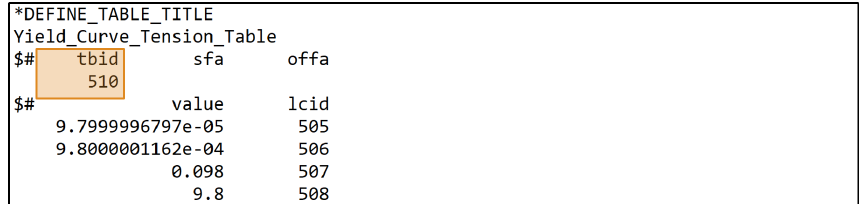
Figure A2. Table definition of strain rate-dependent yield curves (yield curve at specific strain rate) used for MAT_187_SAMP-1 .